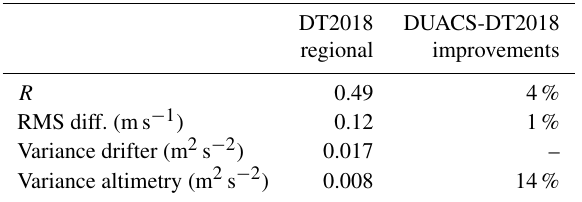
Table 6. RMSE (ms − 1 ) and correlation coefficient between the ab- solute geostrophic velocities derived from DT2018 regional prod- ucts for the Mediterranean Sea, as well as absolute surface veloci- ties as obtained from drifters collected in the basin. The variance of the datasets (m 2 s − 2 ) and the data used to conduct the comparison is also displayed. DT2018 DUACS-DT2018 regional improvements R 0.49 4% RMS diff. (ms − 1 ) 0.12 1% Variance drifter (m 2 s − 2 ) 0.017 – Variance altimetry (m 2 s − 2 ) 0.008